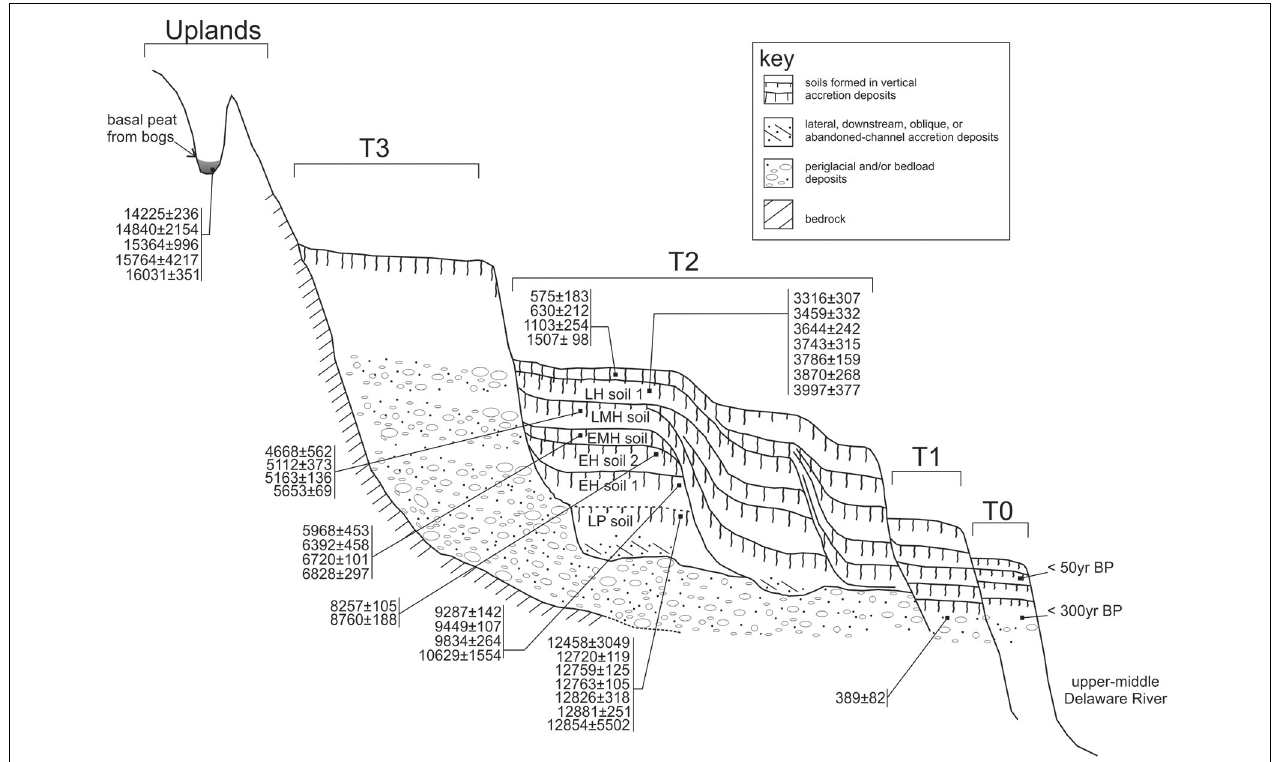
FIGURE 2 | Conceptual soil stratigraphic model for the Delaware River valley study area based on previous work (Witte, 2001, 2012; Witte and Epstein, 2005; Stinchcomb et al., 2012). The calibrated radiocarbon age ranges shown document the range of potential surface and buried soil weathering. Calibrated ages from upland peat bogs document the first appearance of vegetation after Laurentide Ice Sheet recession based on